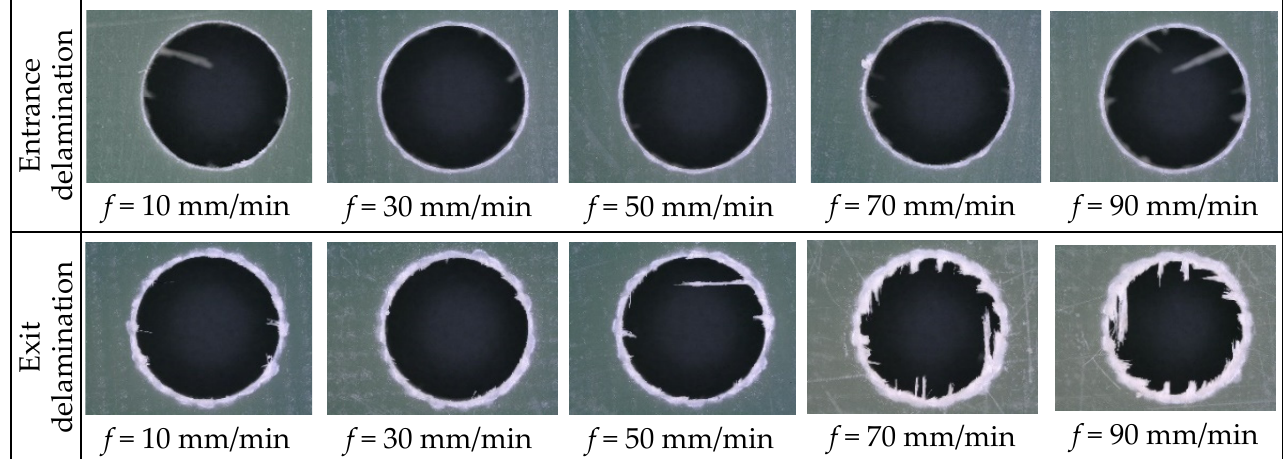
Figure 6. Morphology of entrance and exit at different feed rates ( V c = 85 m/min).